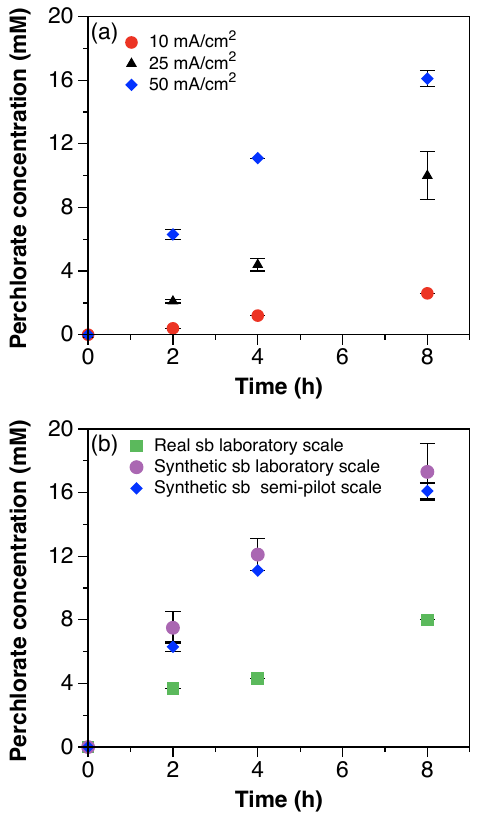
Figure 4. Perchlorate generation during the electrochemical treatment of ( a ) synthetic still bottoms solution with 10, 25 and 50 mA/cm 2 , ( b ) real still bottoms at the laboratory scale, synthetic still bottoms at the laboratory scale, and synthetic synthetic still bottoms in a semi-pilot scale with 50 mA/cm 2